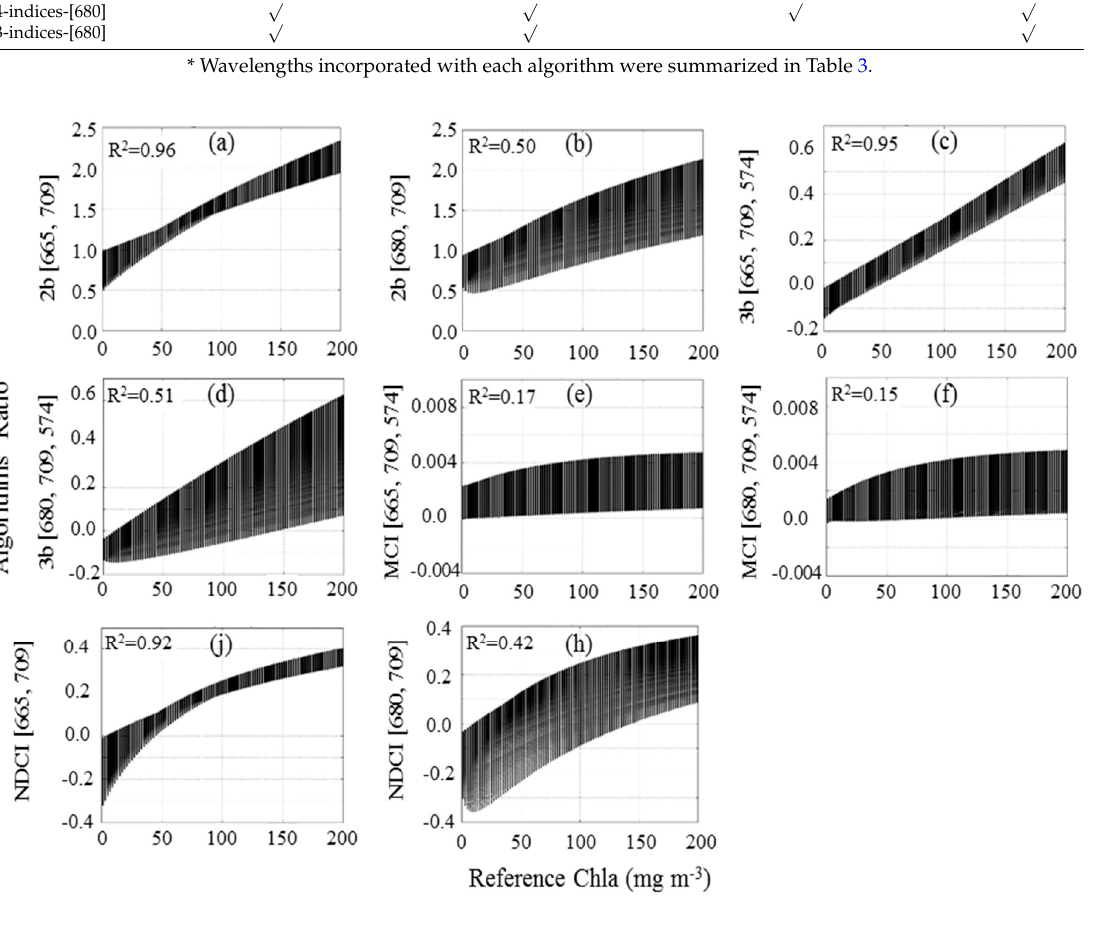
Figure 4. Scatter plots of reference Chla versus algorithms indices for the 500,000 simulated reflectance spectra. ( a – h ) represent indices of eight algorithms mentioned in Table 3.